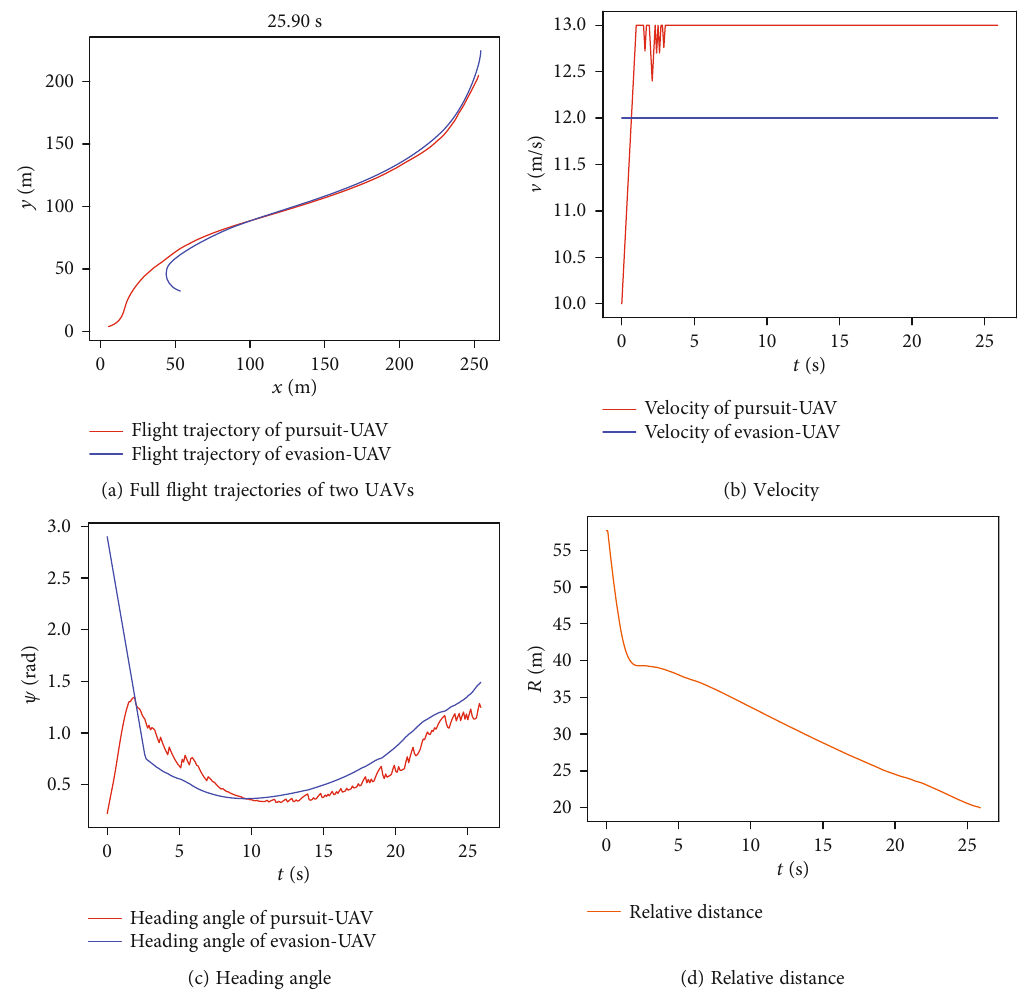
Figure 15: Flight trajectories and test results using